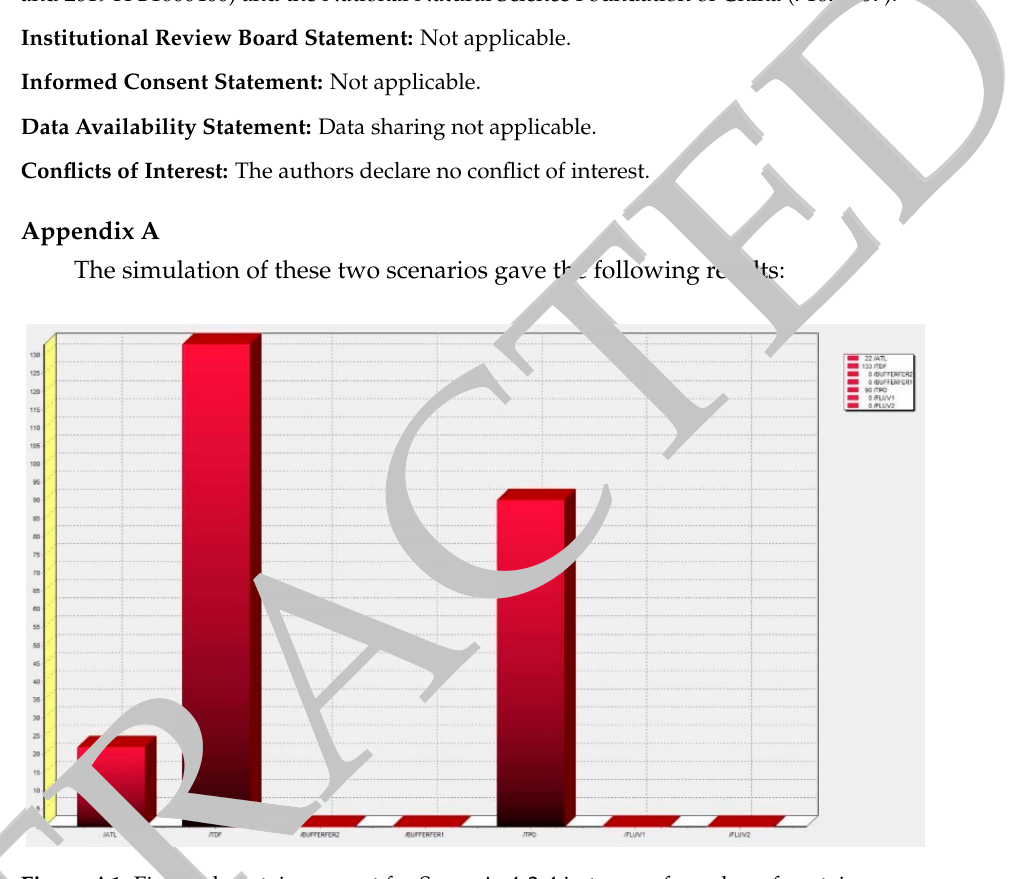
Figure A1. Finished container count for Scenario 4-2-4 in terms of number of containers.